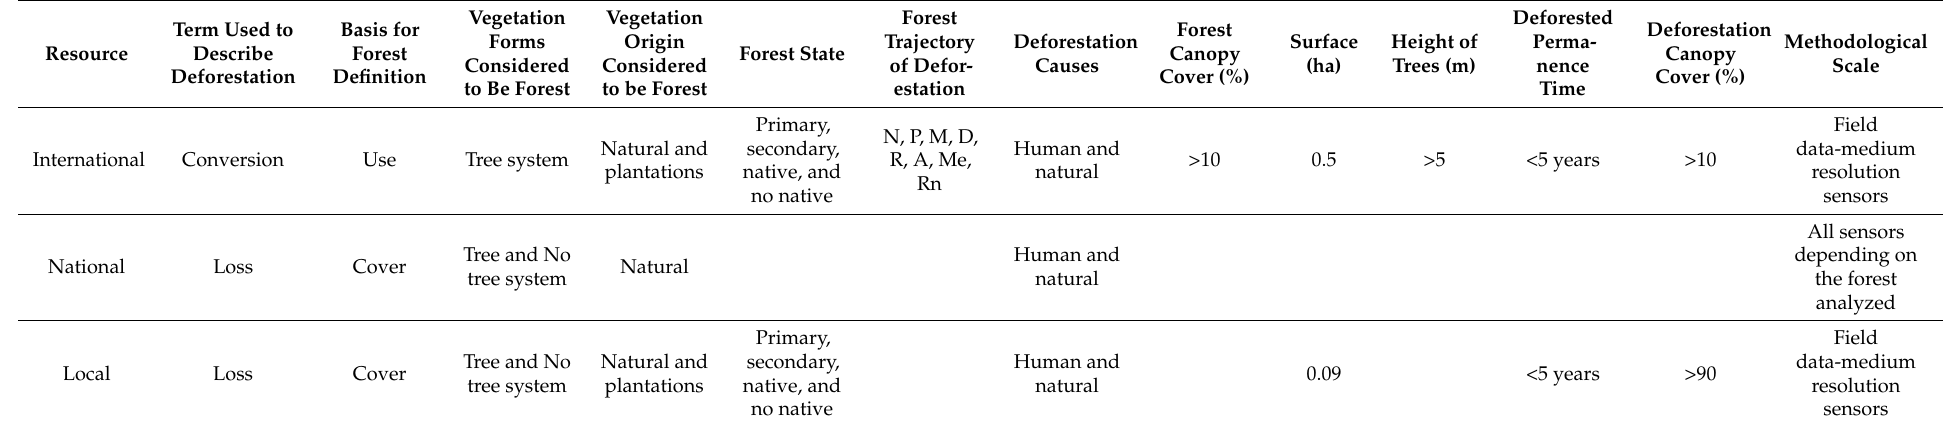
Table 2. Analyses of the conceptual reference framework for deforestation CRFforD.